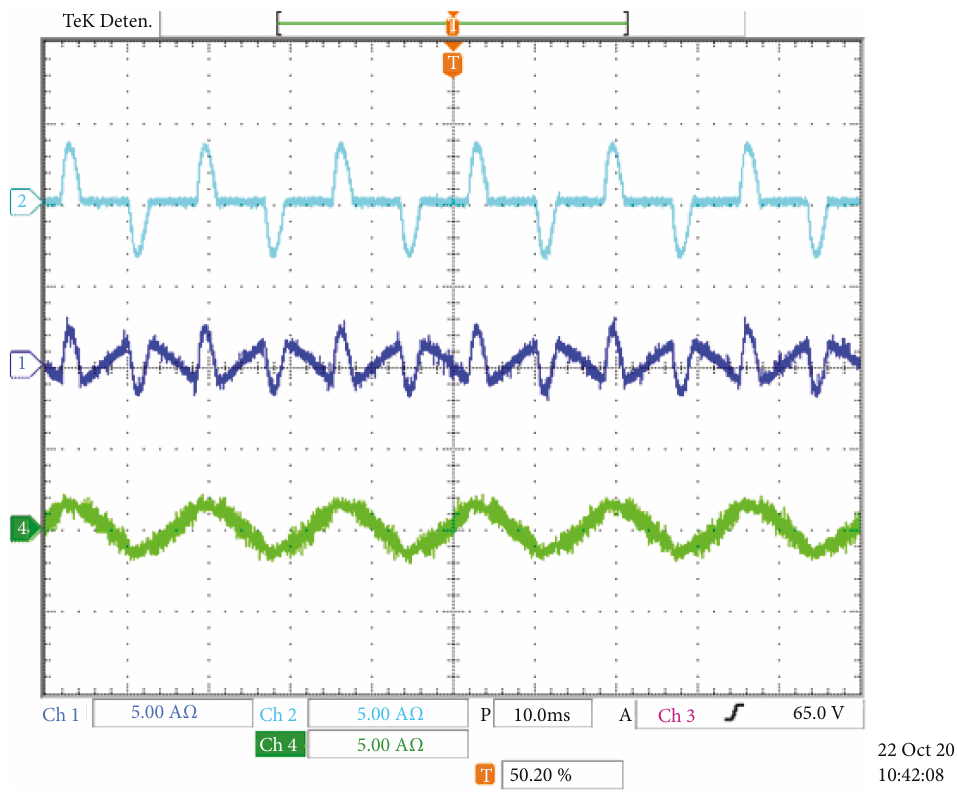
Figure 10: Experimental results when the converter operates only as an active fi lter. From top to bottom: load current (5 A/div), inverter current (5 A/div), and grid current (5